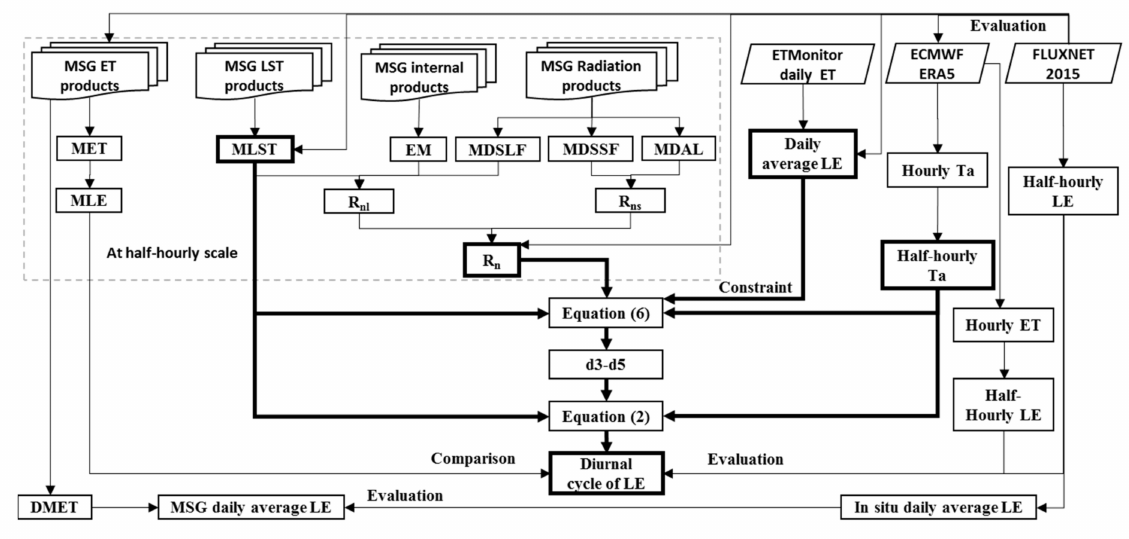
Figure 1. Study of